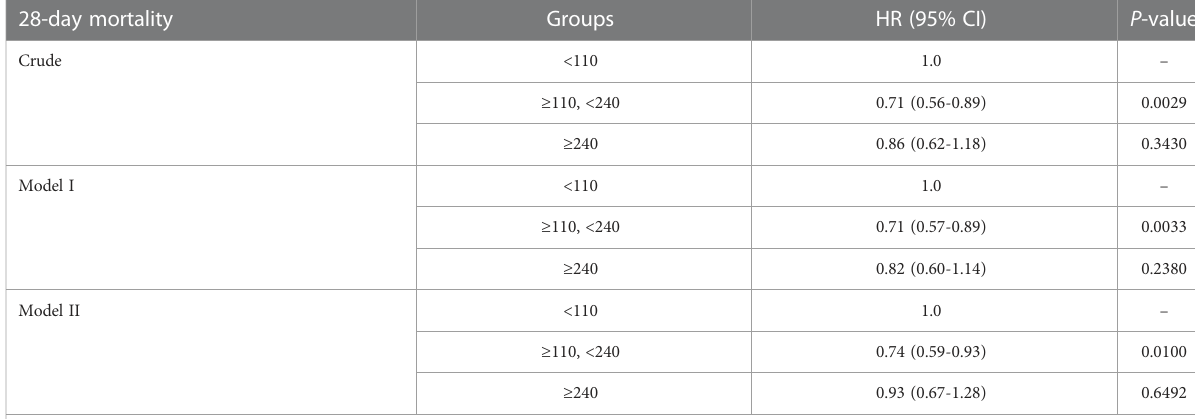
TABLE 4 Associations between in fl ection point grouping of glucose and 28-day mortality. 28-day